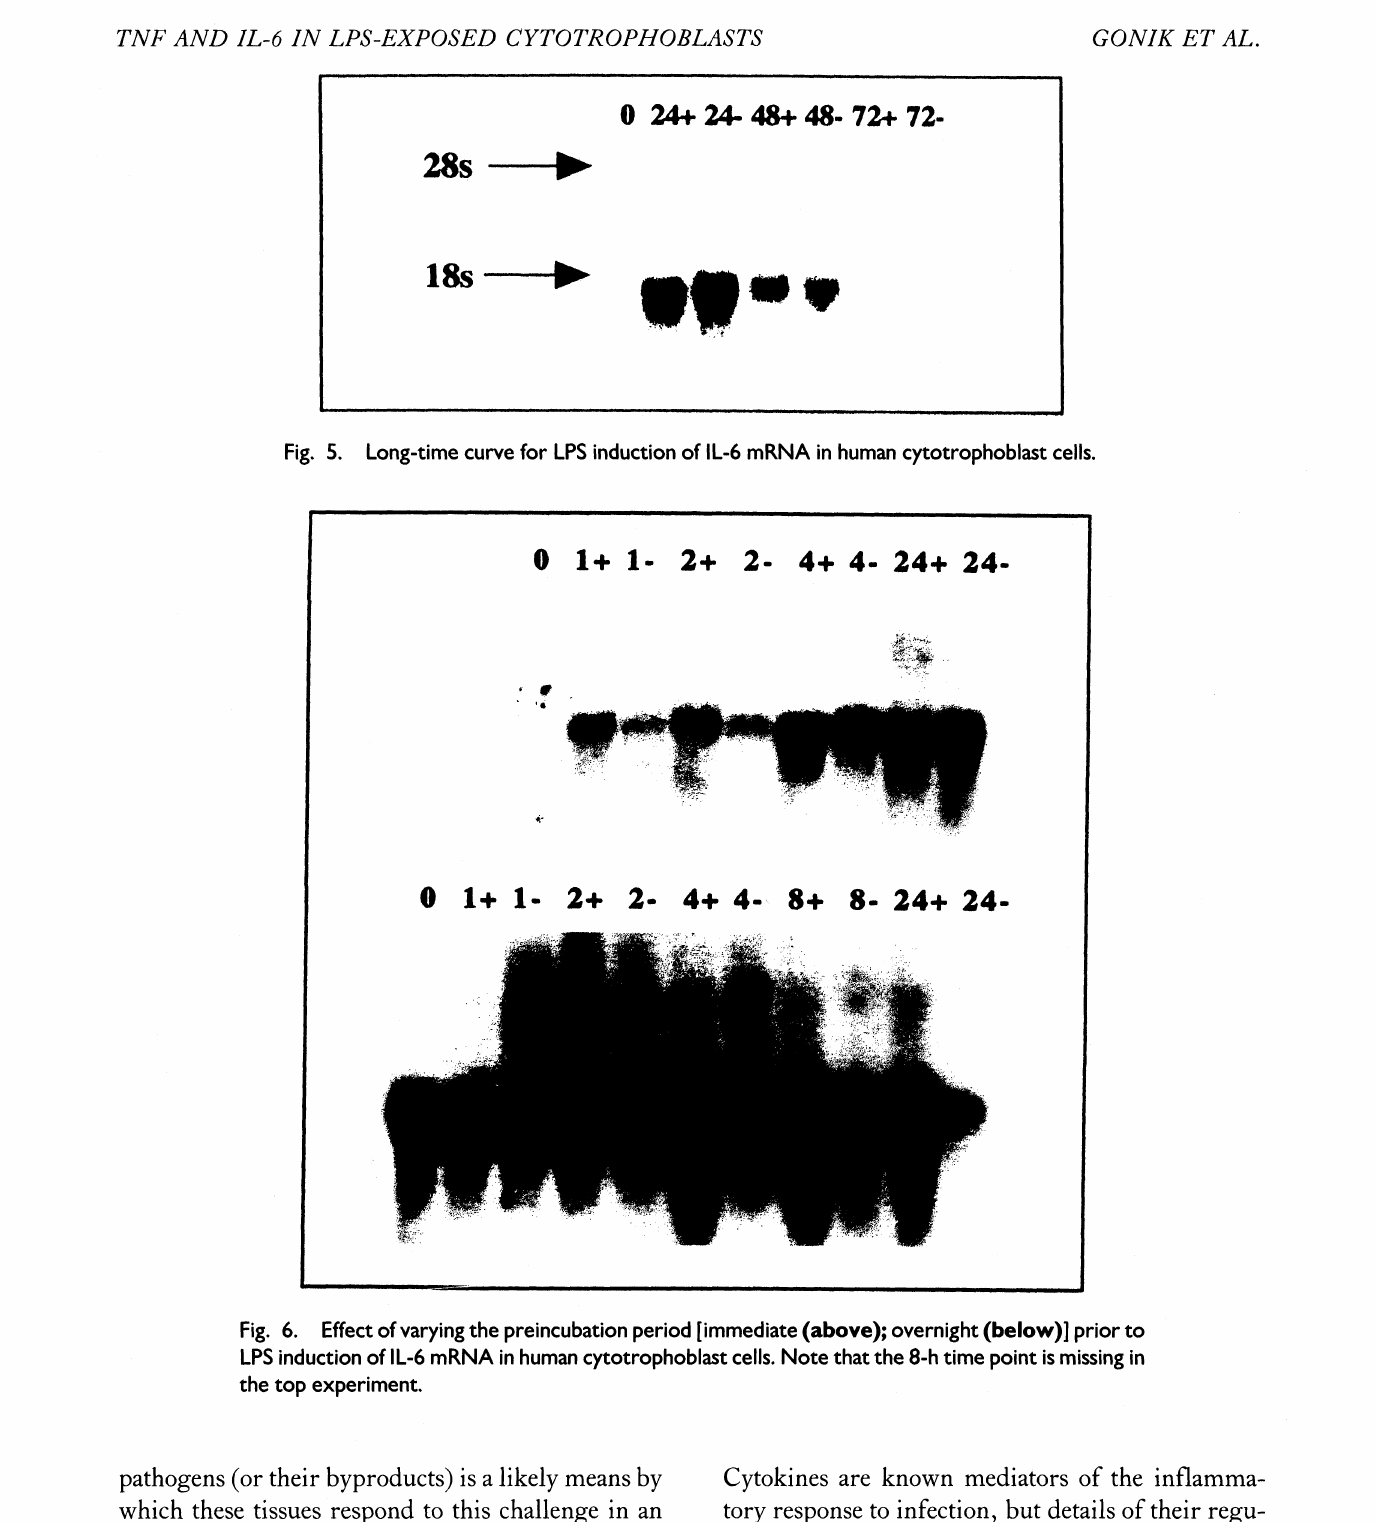
Fig. 5. Long-time curve for LPS induction of IL-6 mRNA in human cytotrophoblast cells.